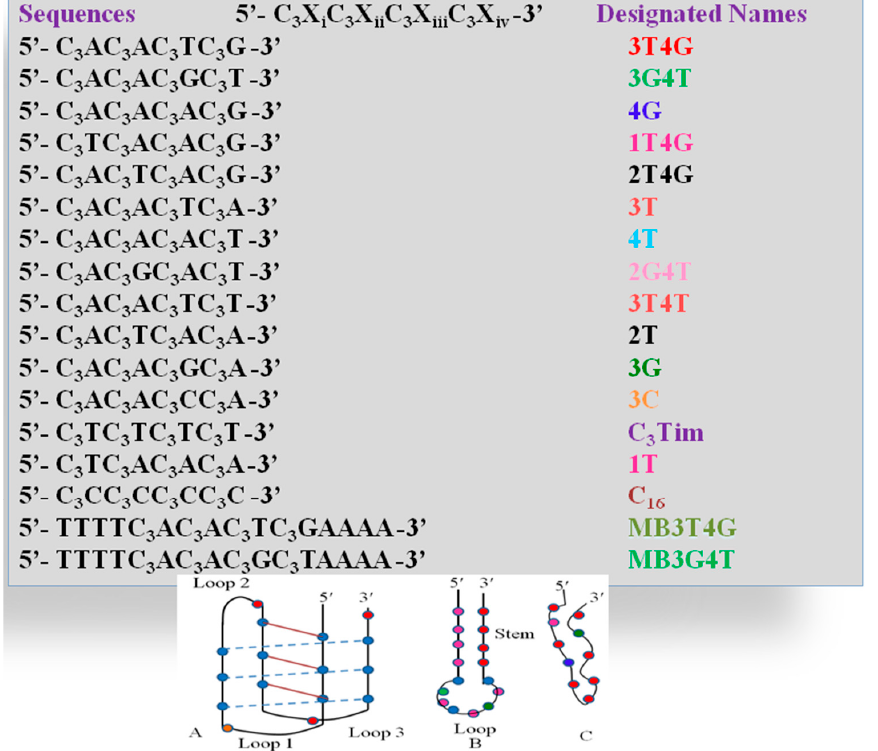
Scheme 1. ( Top ): Sequences of all the single stranded DNA templates and their corresponding label names, which are used in the study; ( Bottom ): Unusual motifs which the DNA templates adapt during the Ag-NC formation; ( A ) C 4 imotif; ( B ) Hairpin loop; ( C ) Random fold.